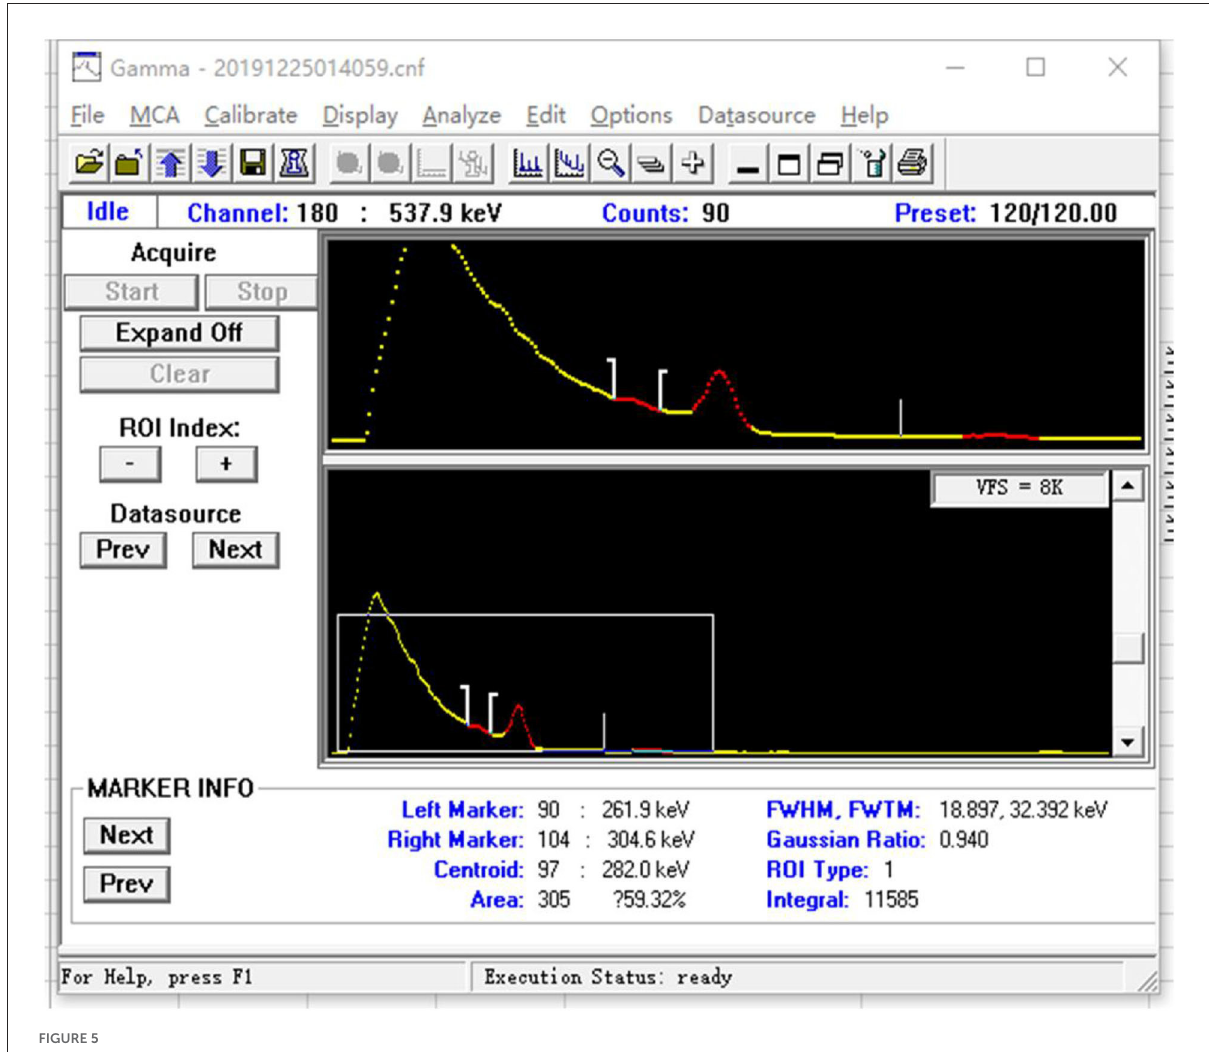
FIGURE5 (Thyroidea) Energy spectrum